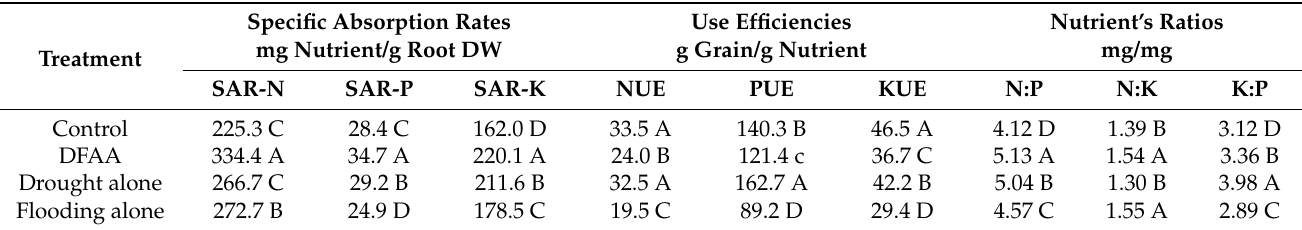
Table 3. Specific absorption rates (SAR), nutrient use efficiencies (NUE, PUE and KUE) and nutrient ratios in rice under different water stresses at maturity.